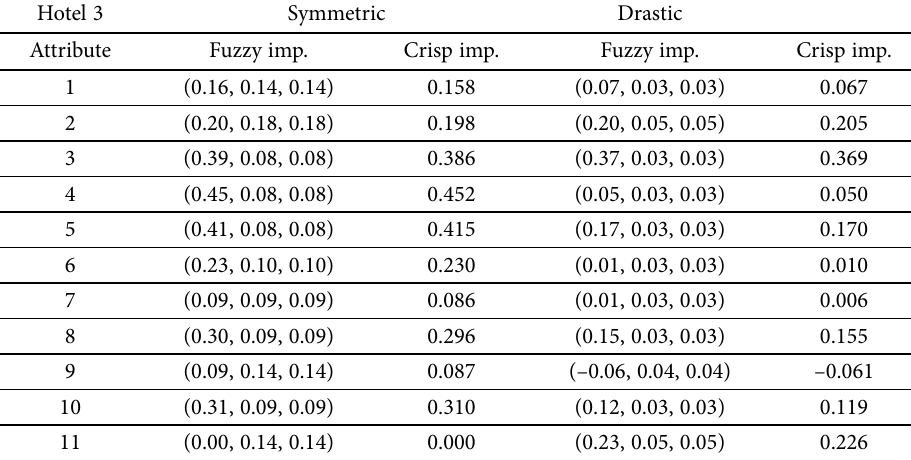
Table 8. Fuzzy importance and crisp importance of attributes – Hotel